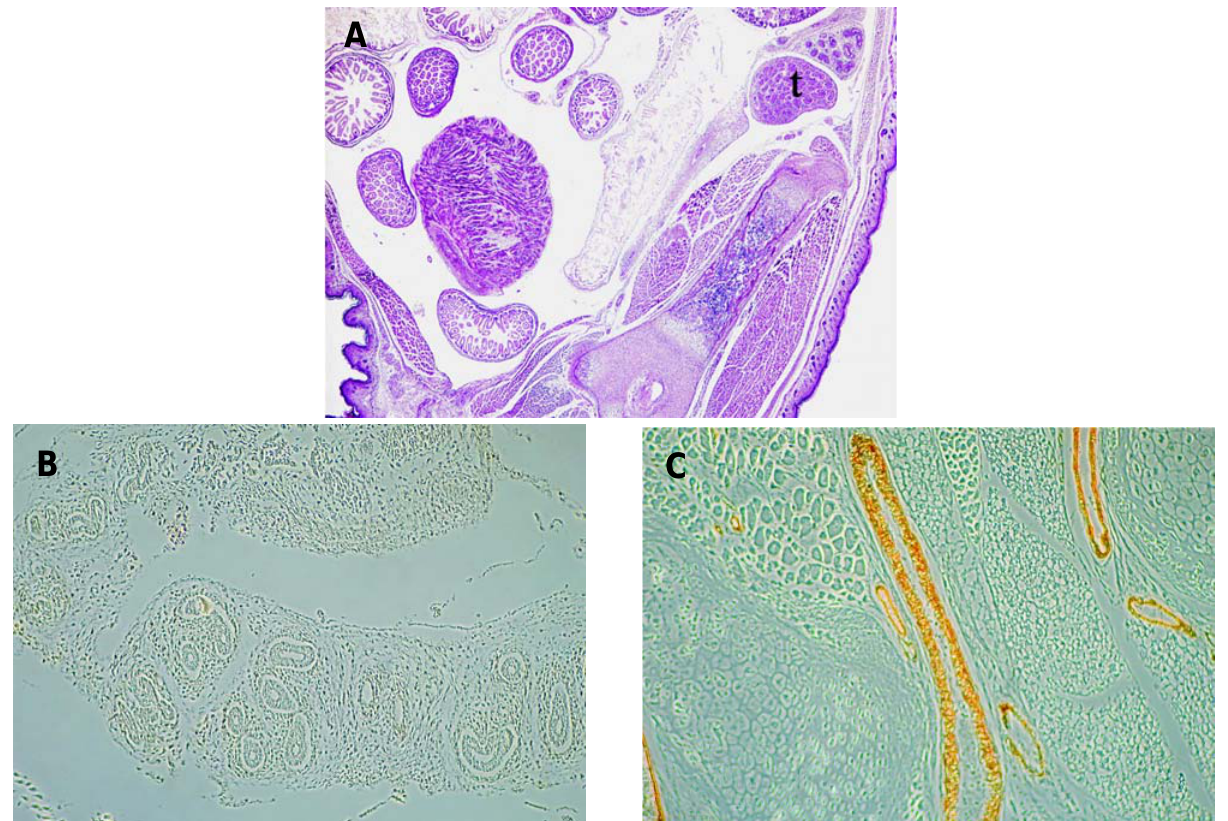
Figure 2 – A) Sagittal section of a homozygous Insl3 male mutant mouse with epididymis and testis (t) located in proximity to the